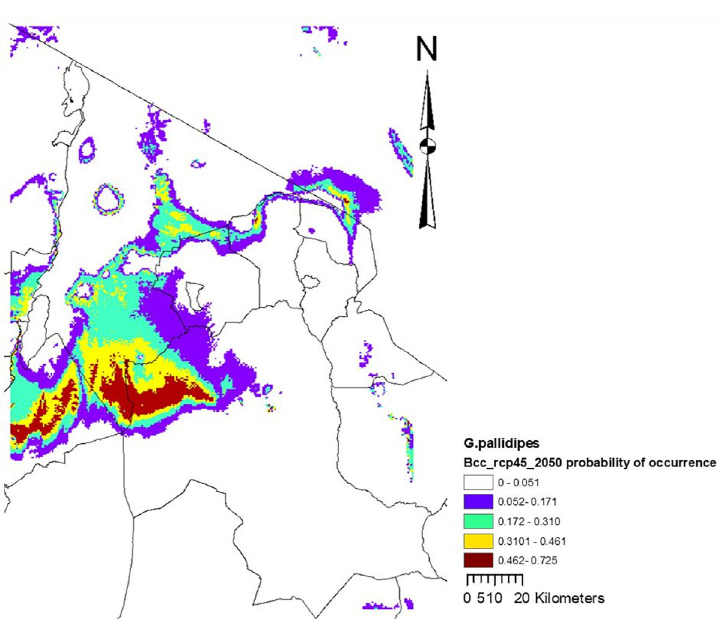
Fig 5. Midcentury (2050) climate suitability map for the best performing model with the G . pallidipes occurrence data, including all 4 variables. In these maps we see that the probability of occurrence decreases with time (comparing current and midcentury) from the maximum values of 0.919 to 0.725, with shrunk habitat.